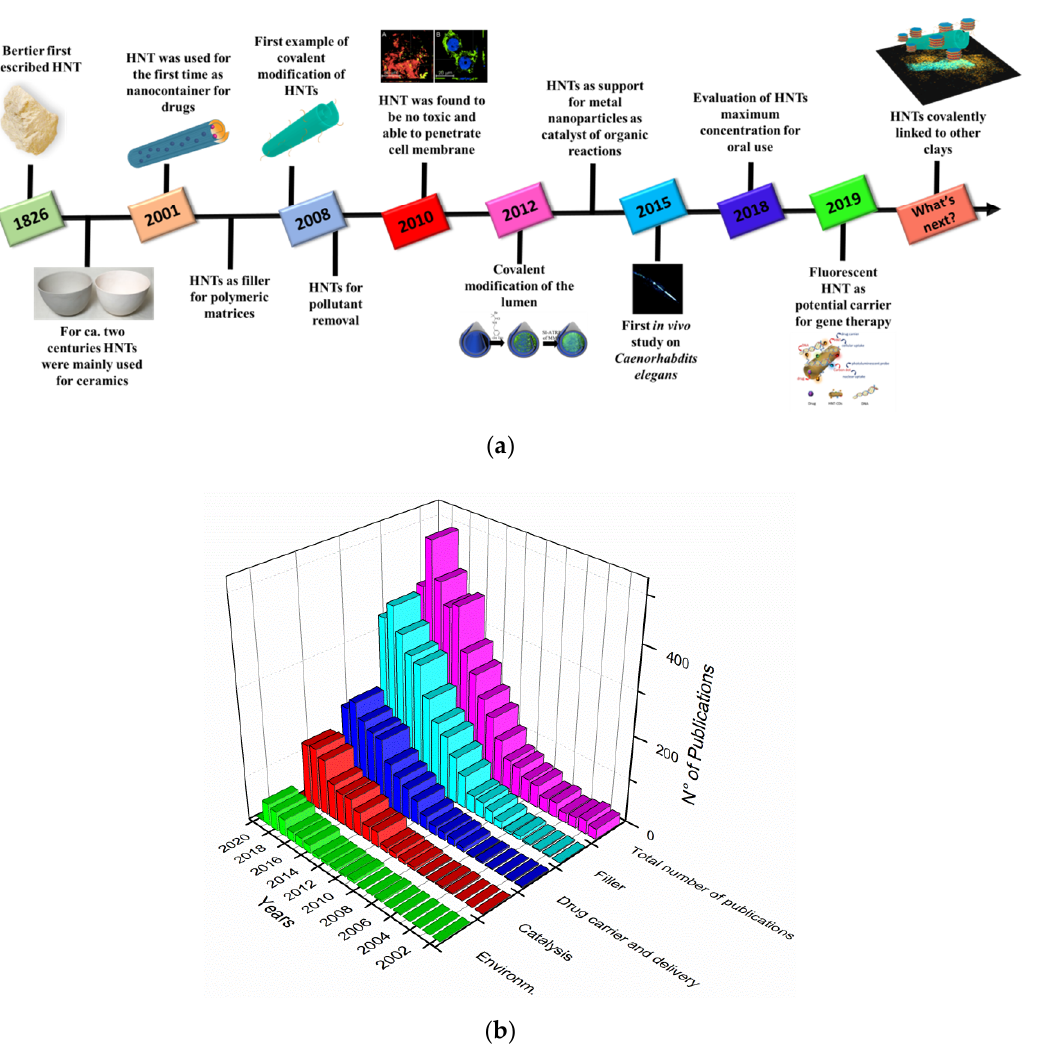
Figure 2. ( a ) A brief timeline for the development of HNTs; ( b ) Number of publications on HNTs sorted by year and for application. Data were collected from “Scopus”. The word “halloysite” is keyed into the “topic” search box (date of search: 22 September 2020). Adapted with permission from [11– 15].